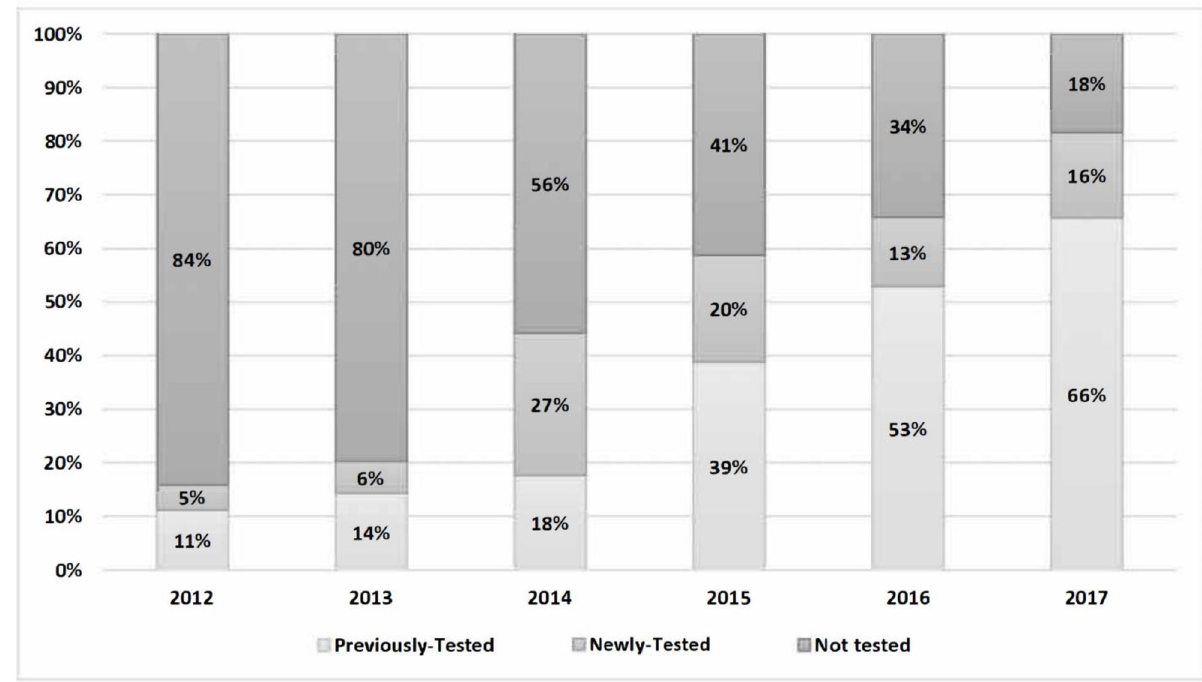
Fig 1. Screening rates for eligible patients, by year.